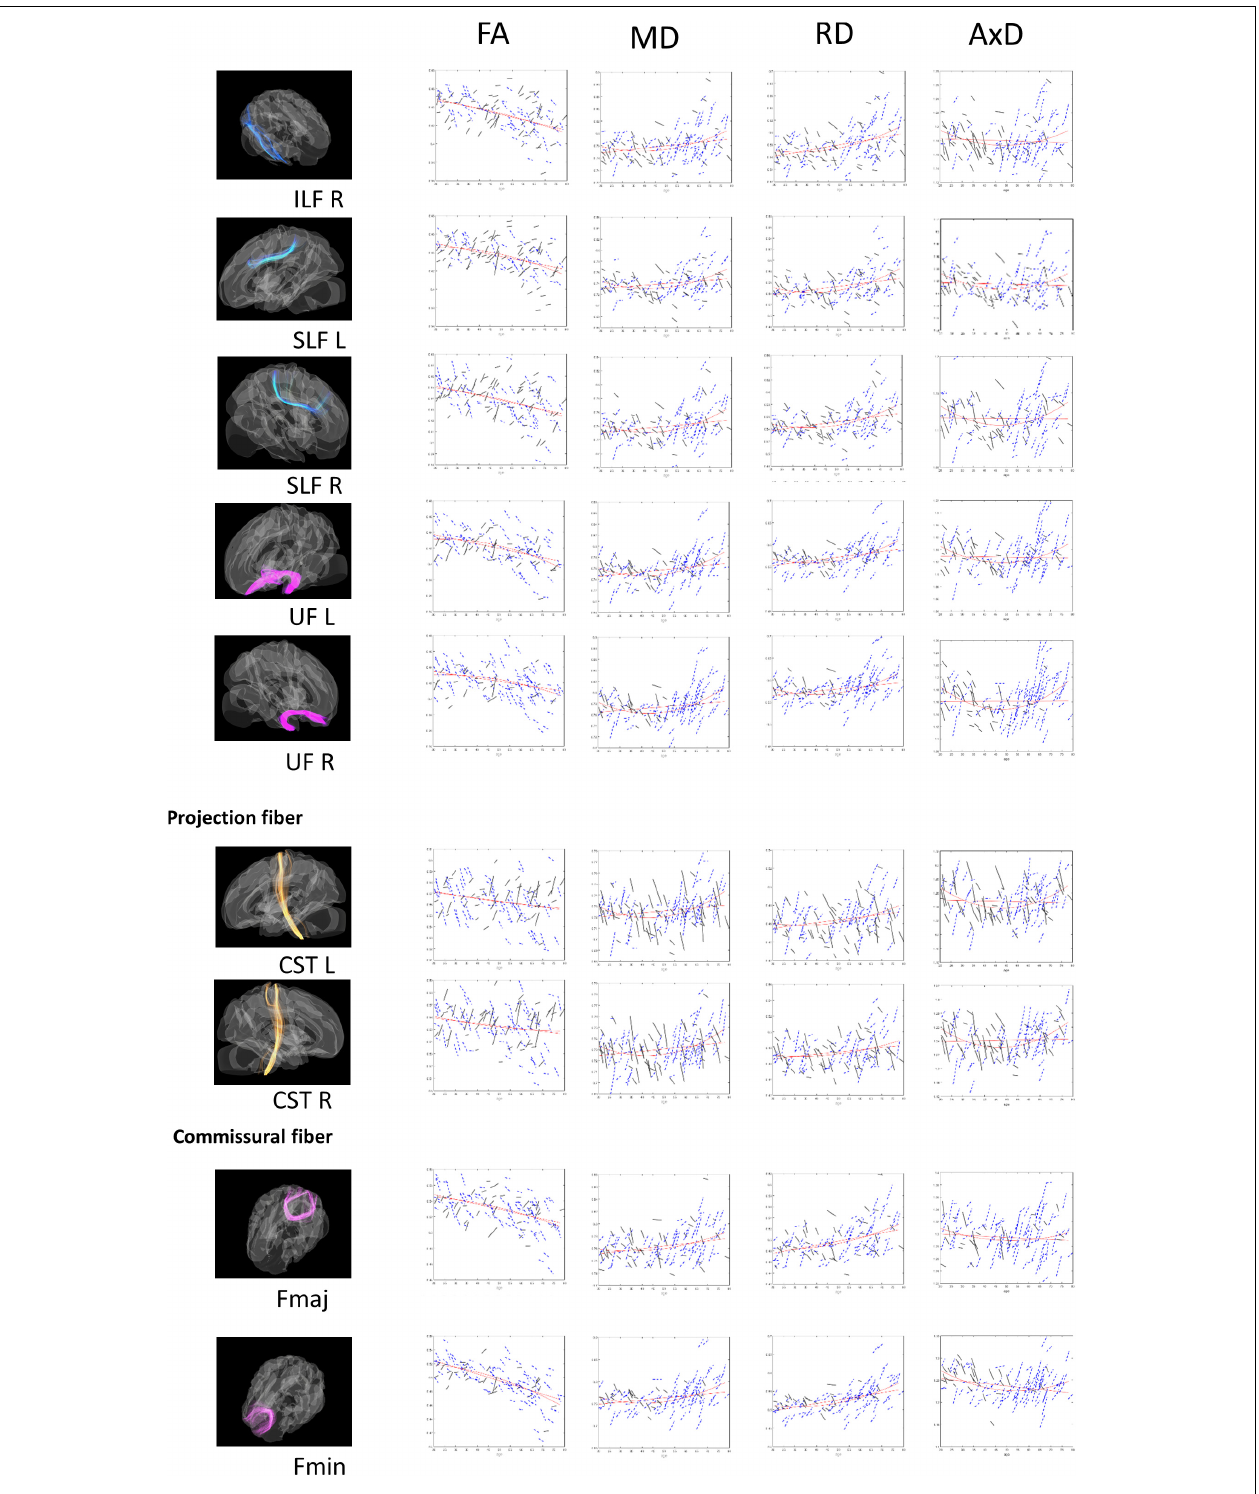
FIGURE 1 | Tract-of-Interest for DTI (FA, MD, RD, and AxD) and their relationships with age. The spaghetti plot that connects the repeated measurements for time point 1 (TP1) and time point 2 (TP2). Tract-of-Interest for DTI measures (FA, MD, RD, and AxD) and their relationships with age is shown in the figure, respectively. Black solid lines denote the better white matter integrity for TP2 than TP1. Conversely, blue dashed lines denote worse white matter integrity for TP2 than TP1. Red lines denote best fitting linear and non-linear regression lines for cross-sectional data on TP1.